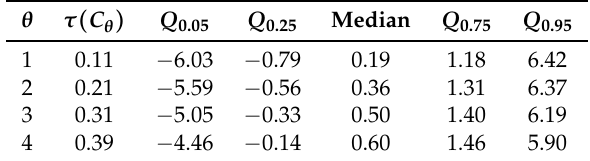
Table 9. Some percentiles of Y = X 1 / X 2 , where ( X 1 , X 2 ) follows Frank Copulas. θ τ ( C θ ) Q 0.05 Q 0.25 Median Q